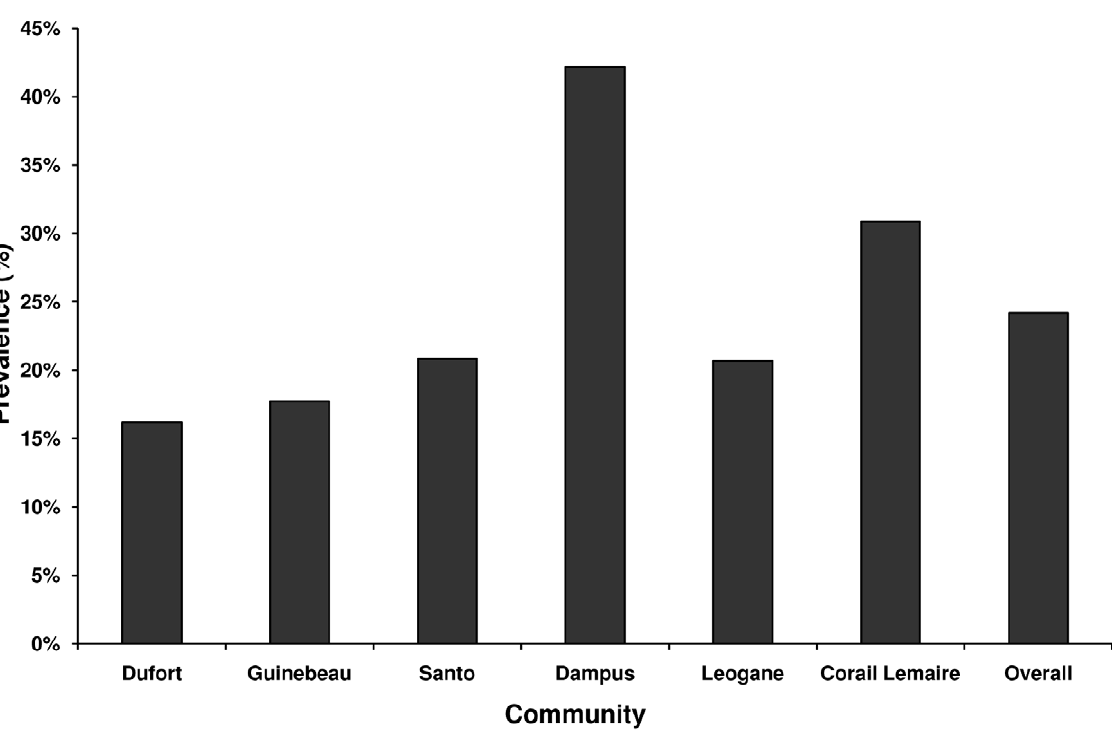
Figure 2. Prevalence of systematic noncompliant individuals by community. Individuals were considered noncompliant if they had reported never participating in MDA (i.e. systematic noncompliance).